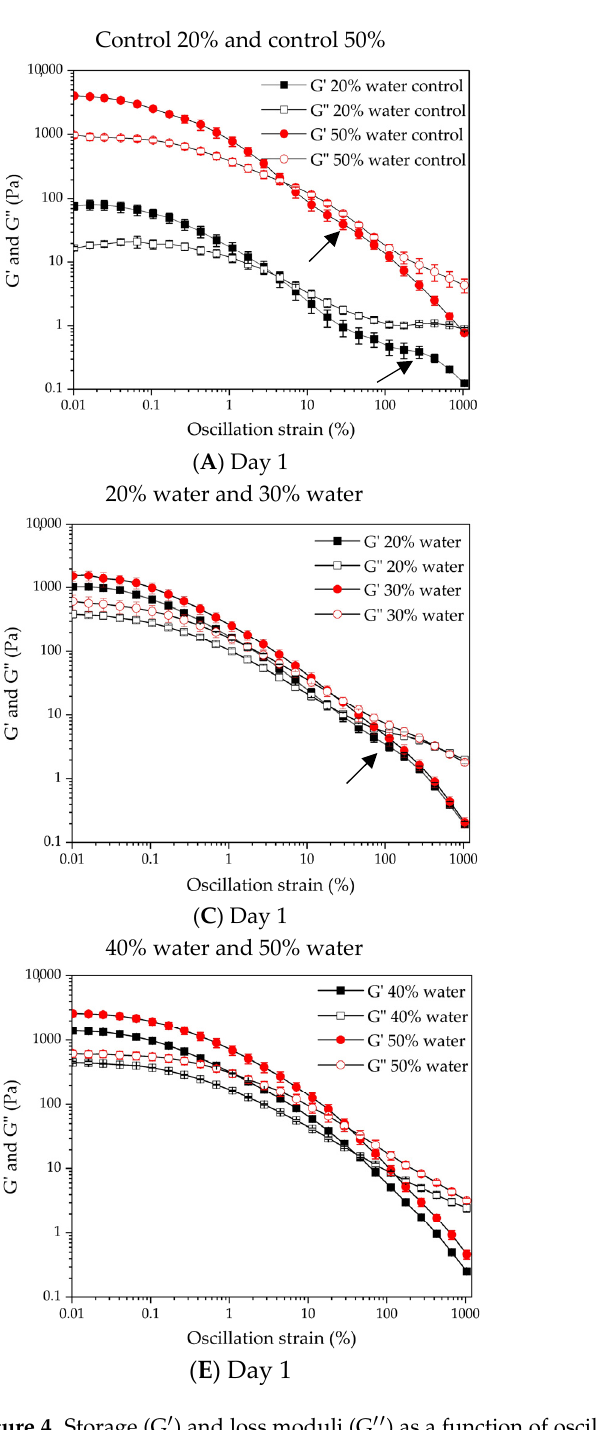
Figure 4. Storage (G (cid:48) ) and loss moduli (G (cid:48)(cid:48) ) as a function of oscillation strain for water-in-oil emulsions with water contents from 20 to 50 wt.% and 1.5 wt.% LMP in the aqueous phase. Control emulsions were made without LMP in the aqueous phase. Data collected on day 1 ( A , C , E ) and day 30 ( B , D , F ) are shown for control emulsions ( A , B ), 20 and 30 wt.% water emulsions ( C , D ), and 40 and 50 wt.% water emulsions ( E , F ). The arrows in some figures indicate peaks in G (cid:48)